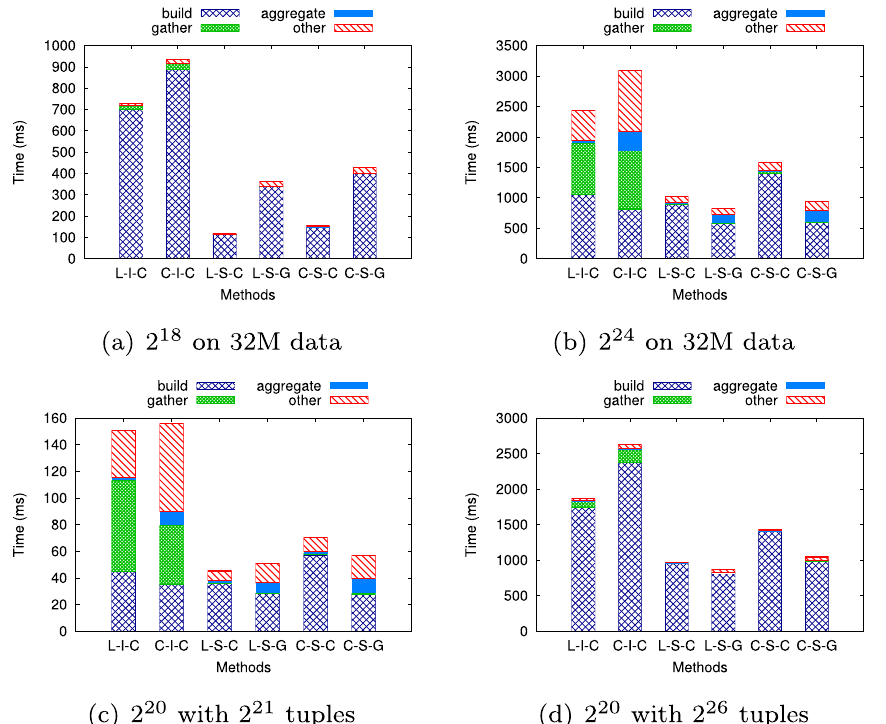
2 26 tuples) in Fig.